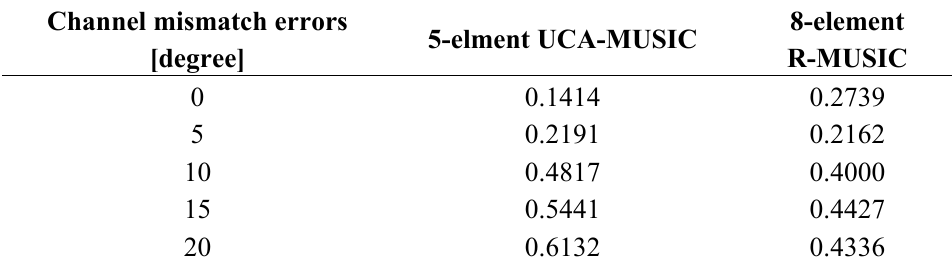
Table 1. The RMSE versus different channel mismatch